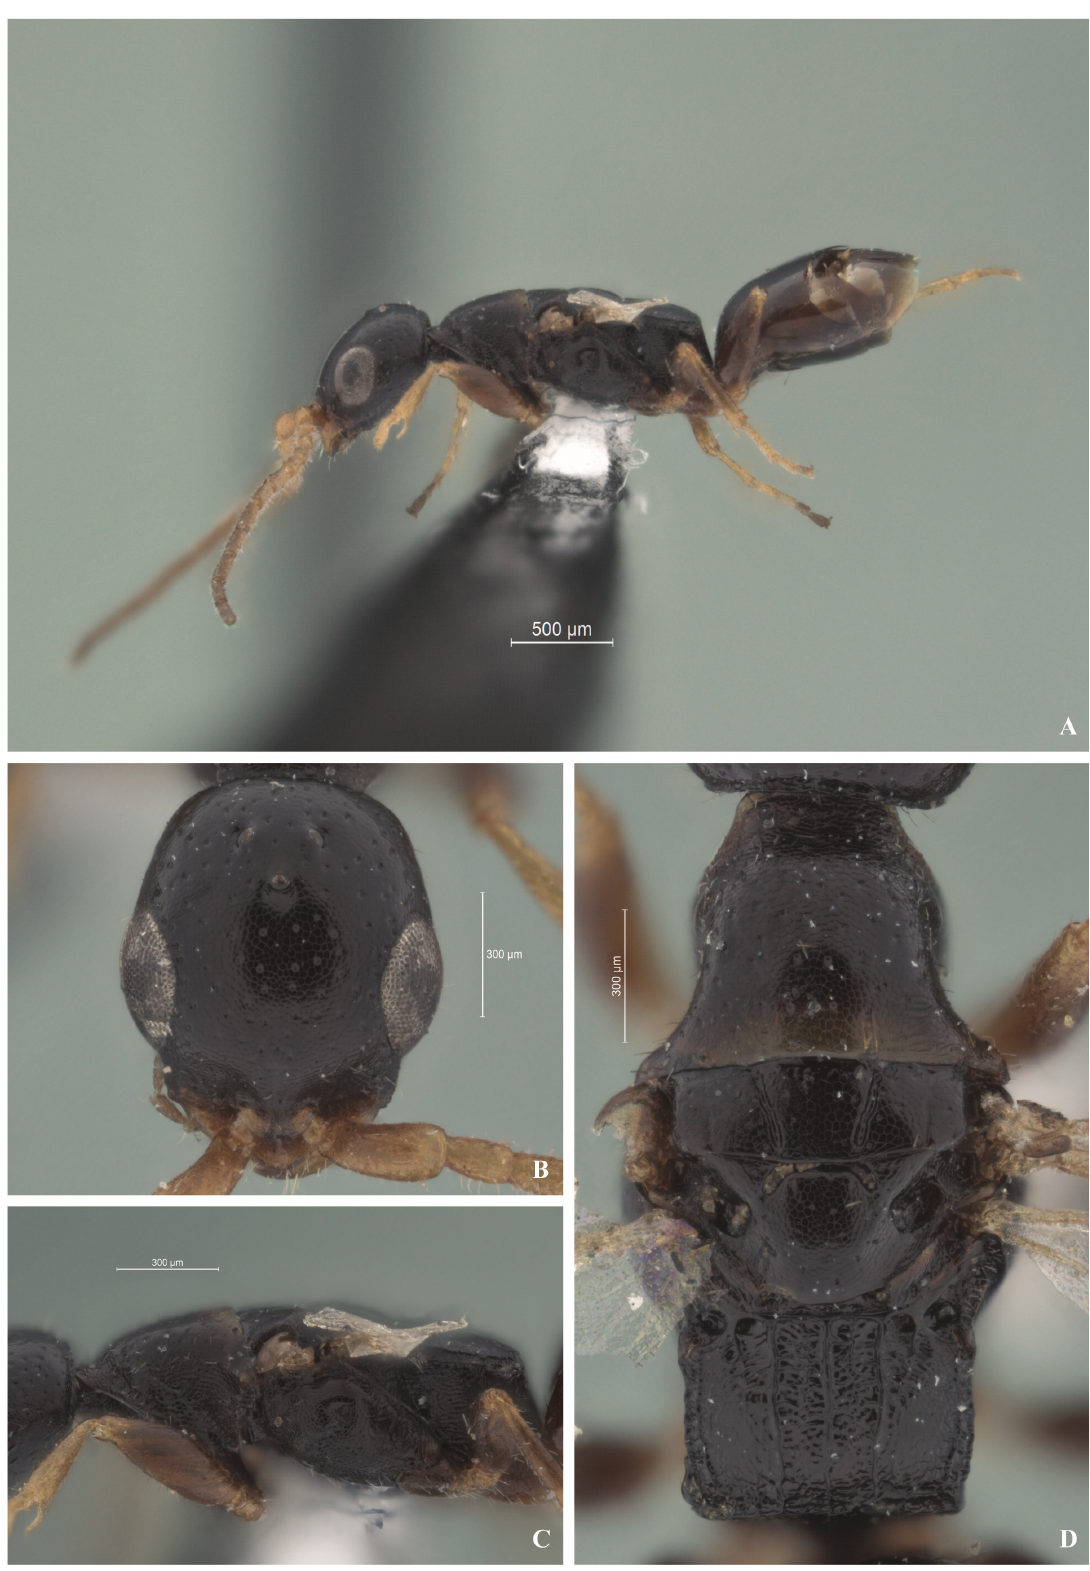
Fig. 2. Bradepyris jordanicus sp. nov. Holotype, ♂. A . Lateral habitus. B . Head in dorsal profile. C. Mesosoma in lateral profile. D . Mesosoma in dorsal